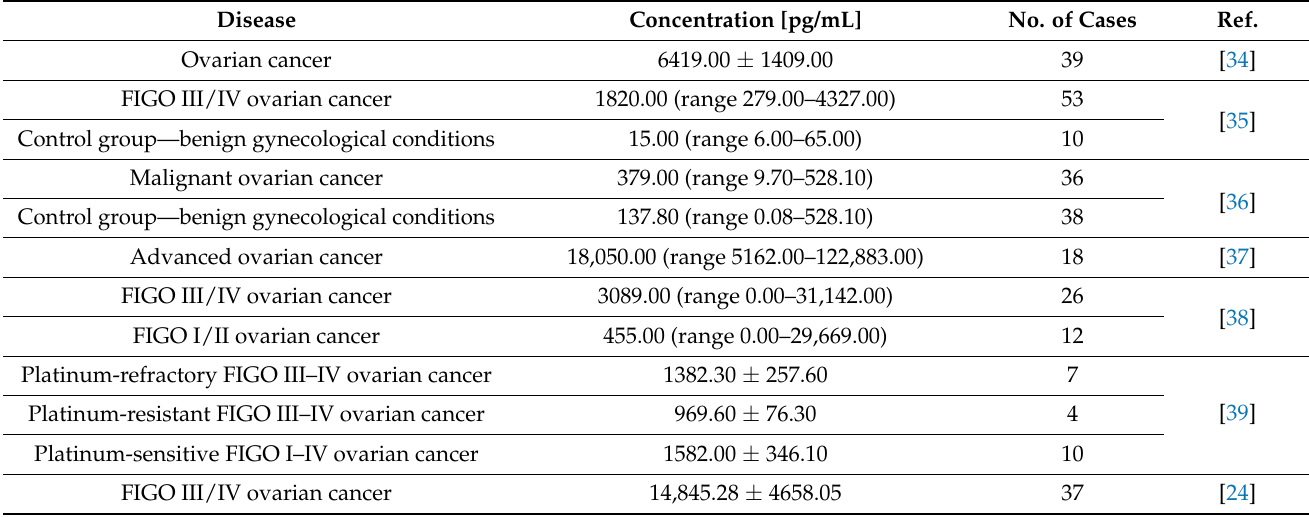
FIGO I-IV—The International Federation of Gynecology and Obstetrics classification of ovarian tumors. Correspondingly, values of IL-6 concentrations in blood plasma/serum presented in